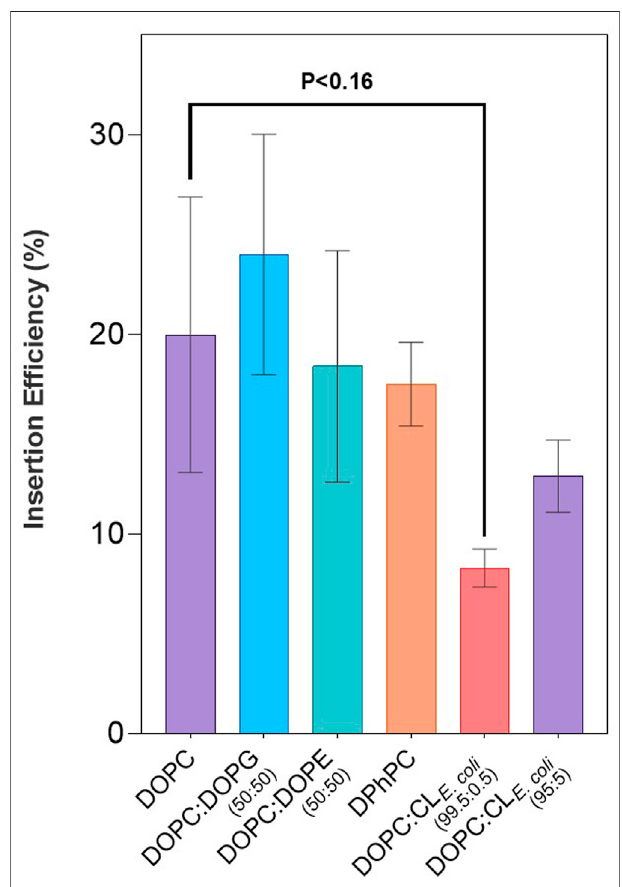
FIGURE 2 | LeuT expressed in PURExpress ® IVTT systems in the presence of liposomes comprising various lipid compositions as presented in Table 1 and Table 2 . Spontaneously inserted protein was quanti fi ed using LSC counting of Methionine, L-[ 35 S] incorporated into LeuT. Insertion ef fi ciency is represented as a percentage of protein in the top fraction over the total yield of protein synthesized. Highlighted here are the results of lipid optimization on LeuT spontaneous insertion ef fi ciencies, comparing various lipid species derived from DO, DPh and Cardiolipin liposome compositions. Errors presented are SEM calculated from ≥ 3